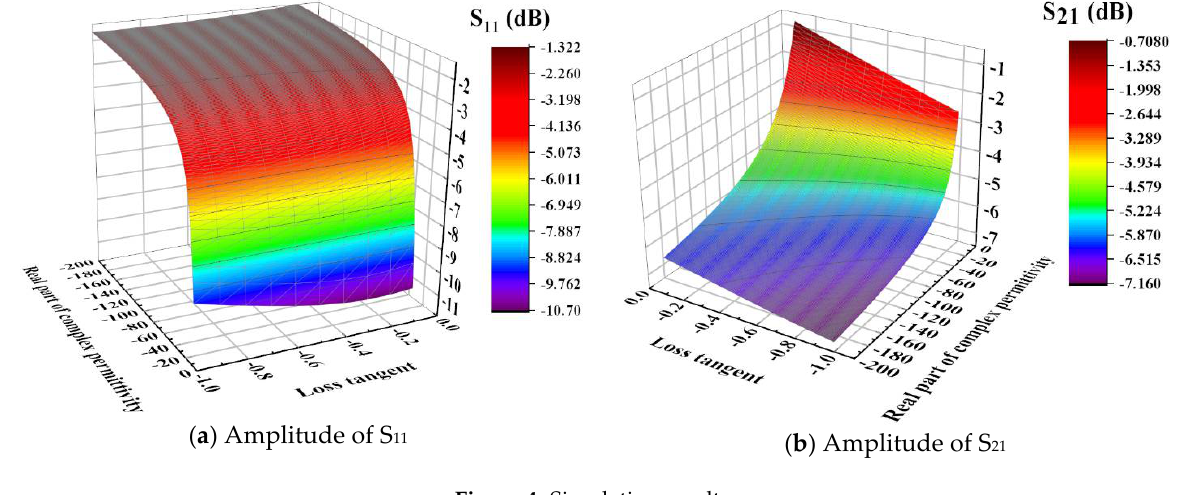
Figure 4. Simulation results.